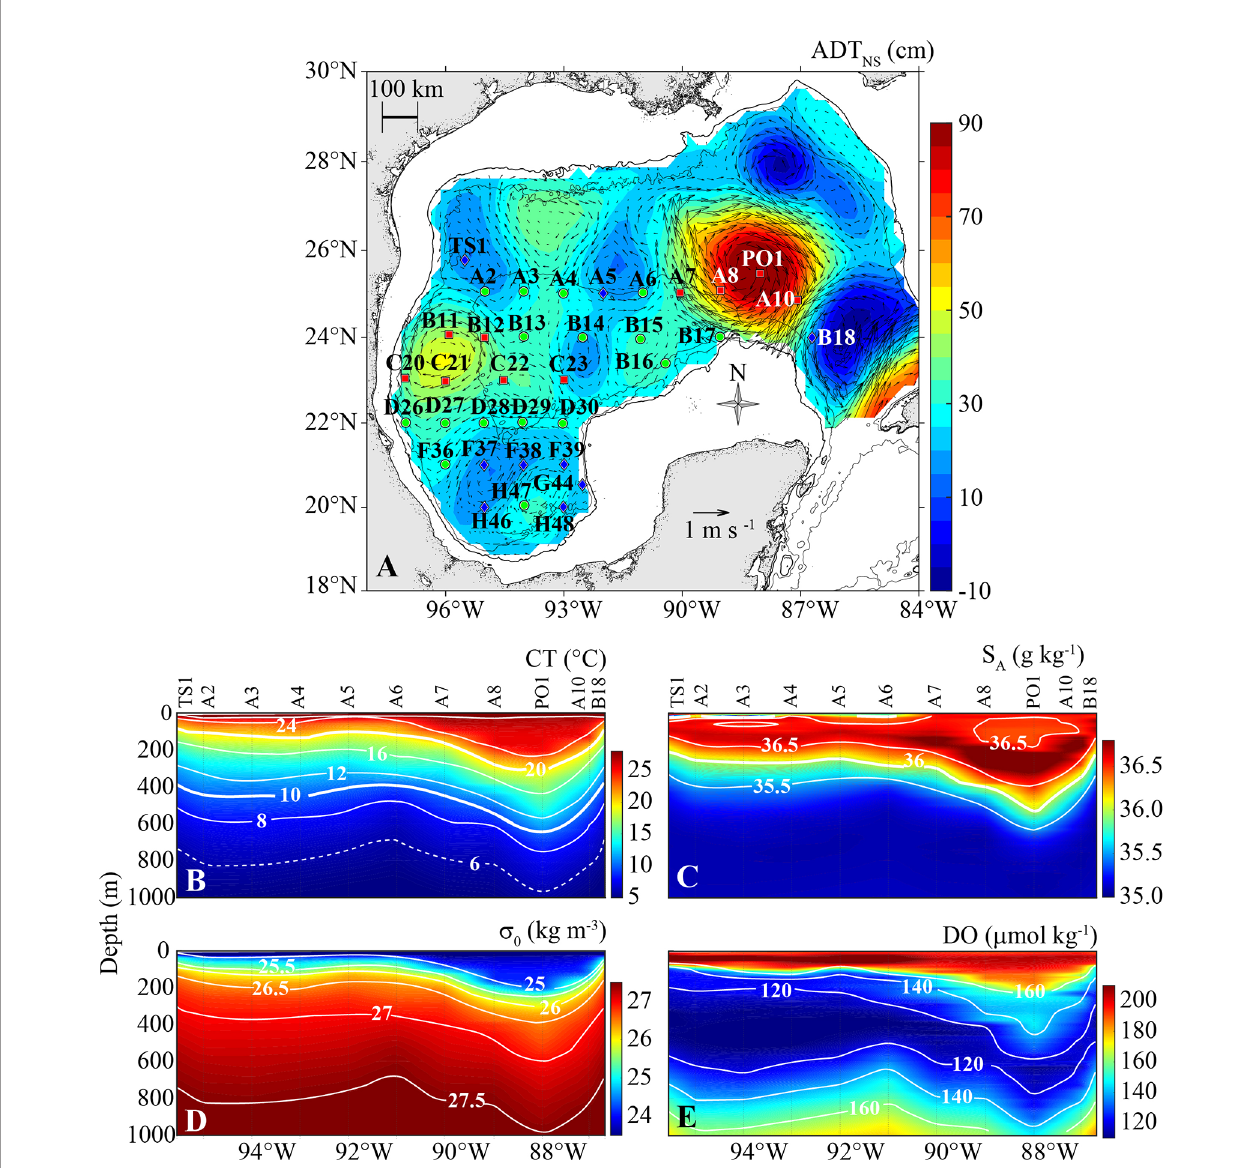
FIGURE 1 | (A) Mean non-steric absolute dynamic topography (ADT NS , cm) during the XIXIMI-5 cruise. The black lines correspond to the 200, 1000, and 3500 m isobaths. The blue rhombuses ( ), green circles ( ), and red squares ( ) correspond to cyclonic (CE), no eddy (NE), and anticyclonic (AE) stations, respectively, which were classi fi ed using the nitracentric classi fi cation. The Loop Current (LC) stations are represented by white labels. The vectors show the surface geostrophic velocity currents derived from horizontal ADT NS gradients. The spatial distribution sections of conservative and non-conservative properties obtained with CTD data for the northernmost transect include: (B) Conservative Temperature (CT, °C), (C) absolute salinity (S A , g kg -1 ) (D) potential density anomaly ( s 0 , kg m -3 ), and (E) dissolved oxygen (DO, µmol kg -1